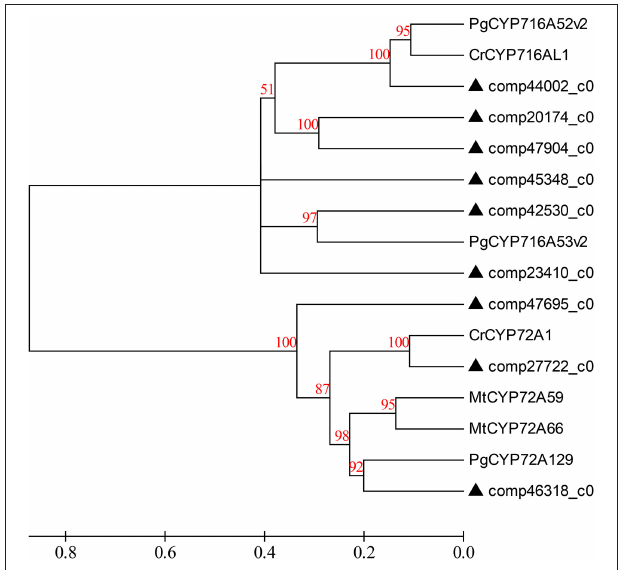
FIGURE 7 | Phylogenetic tree of the D. asperoides CYPs. Phylogenetic tree constructed based on the deduced amino acid sequences for D. asperoides CYPs (filled triangles) and other plant CYPs. Protein sequences were retrieved from NCBI GenBank using the following accession numbers (source organism and proposed function, if any, are given in parentheses): PgCYP716A52v2, AFO63032 ( Panax ginseng , β -amyrin 28-oxidase); CrCYP716AL1, AEX07773 ( Catharanthus roseus, in the biosynthesis of oleanolic acid); PgCYP716A53v2, JX036031 ( P. ginseng, protopanaxadiol 6-hydroxylase); CrCYP72A1, AAA33106 ( C. roseus , secologanin synthase); MtCYP72A59, ABC59078 ( Medicago truncatula , cytochrome P450 monooxygenase); MtCYP72A66, ABC59099 ( M. truncatula , cytochrome P450 monooxygenase); and PgCYP72A129, AEY75218 ( P. ginseng